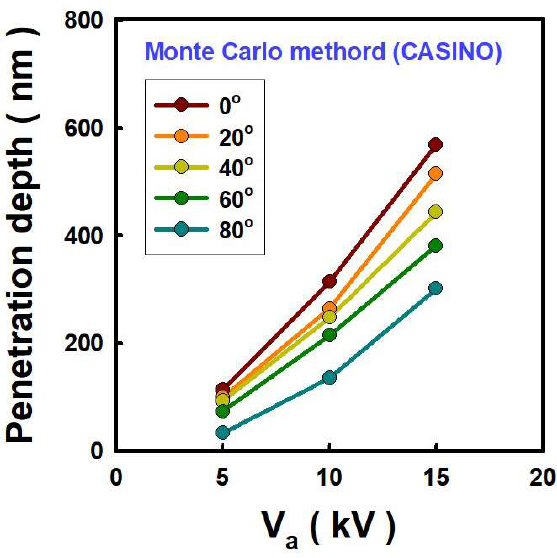
Figure 7. Penetration depth with different anode voltage and electron incident angle injected into Sn.